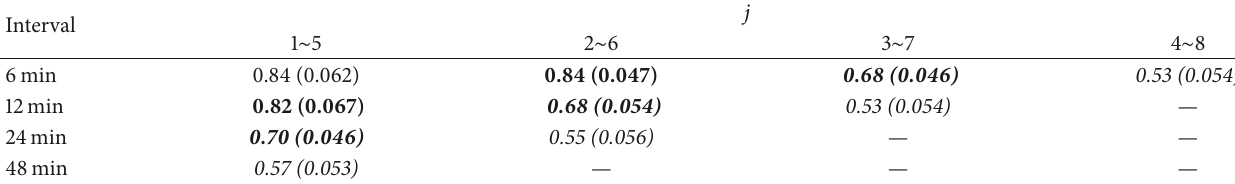
Table 4: Multiscales and multisampling for H of Site 1 (data length = 182855).